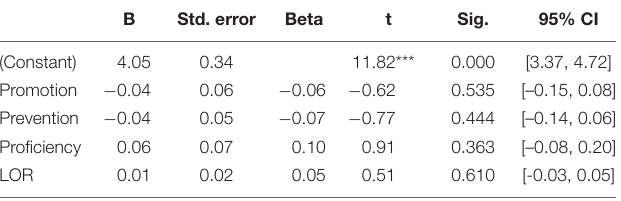
TABLE 7 | Multiple regression results for regulatory focus with DCT IPD- score as the outcome